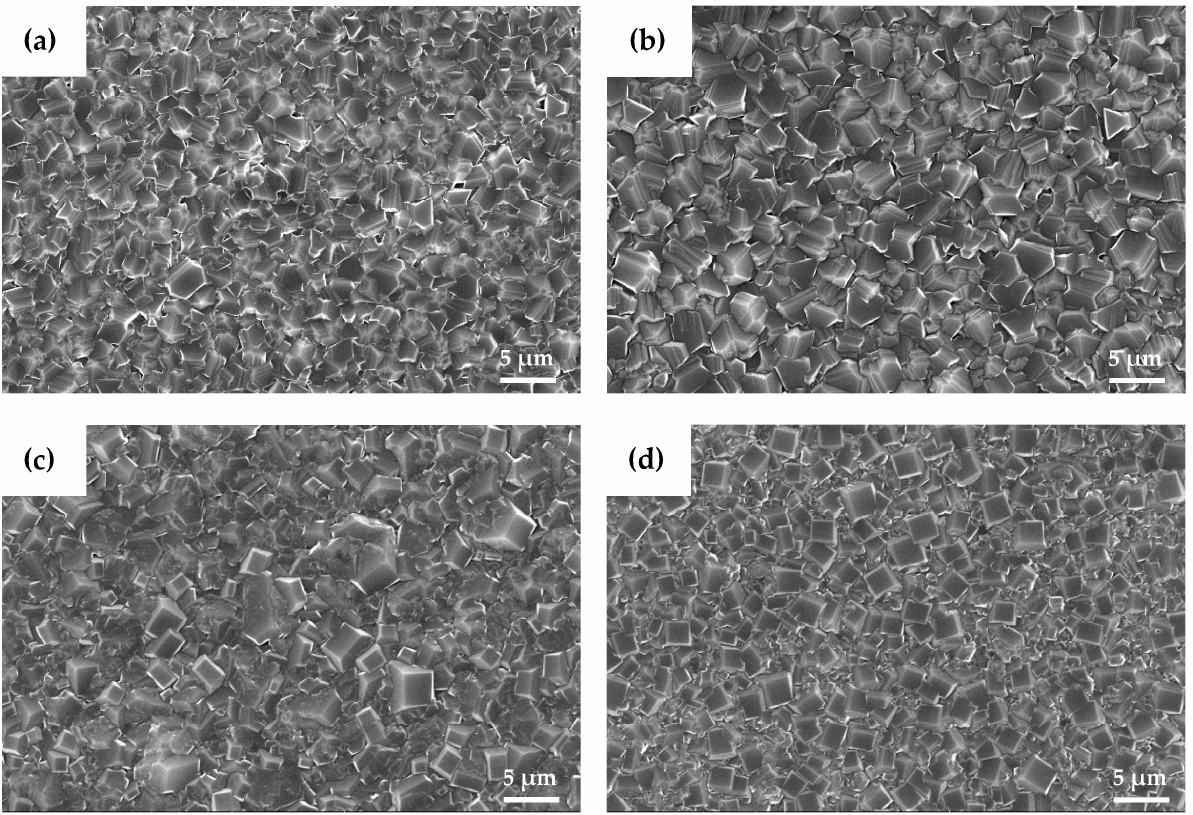
Figure 4. SEM images of CVD diamond films under a dynamic magnetic field with different angular frequencies: ( a ) 0 π rad/s, ( b ) 50 π rad/s, ( c ) 100 π rad/s, and ( d ) 150 π rad/s.